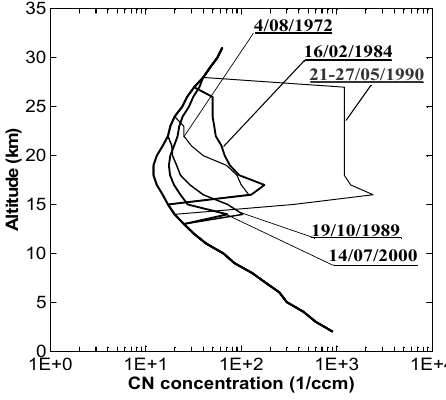
Fig. 2. Model simulations of condensation nuclei (CN) initiated by Figure 2. Model simulations of condensation nuclei (CN) initiated by GLEs.